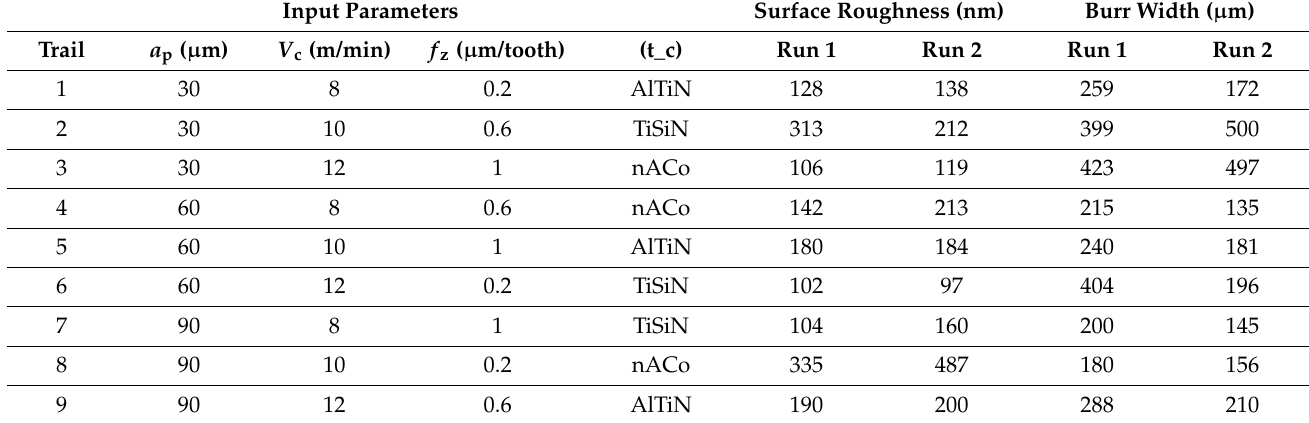
Table 7. Experimental plan using an L9 orthogonal array and the corresponding surface roughness.